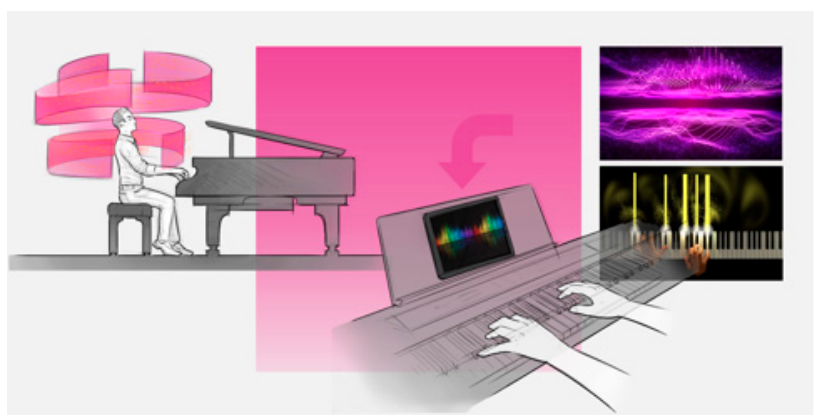
Figure 3. Performance analysis scenario.